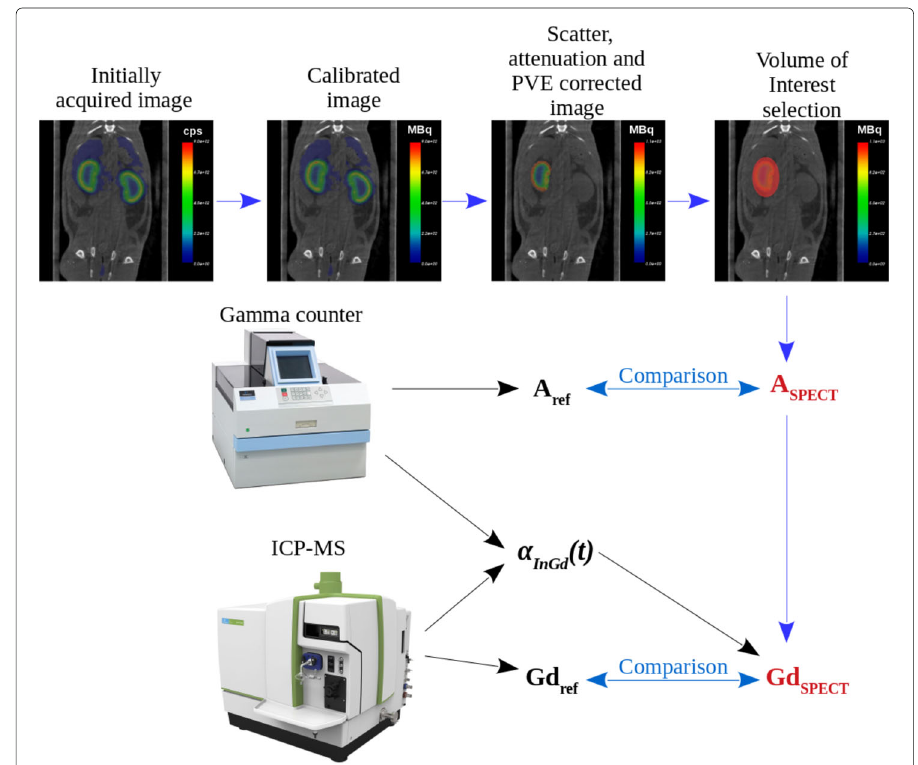
Fig. 1 Main steps of the analysis. Schematic representation of the main steps of the analysis